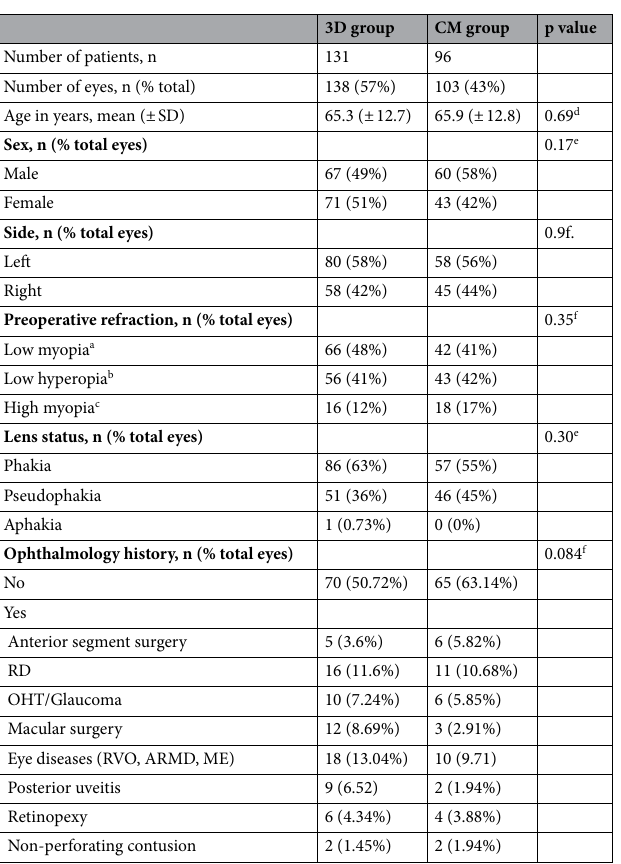
macular edema, OHT ocular hypertension, RD retinal detachment, RVO retinal vein occlusion, SD standard deviation. a Low myopia: spherical equivalent of 0–5.5 D. b Low hyperopia: spherical equivalent of 0–4.5 D. c High myopia: spherical equivalent of < − 6 D or axial length > 26 mm. d Welch’s t-test. e Fisher’s exact test. f